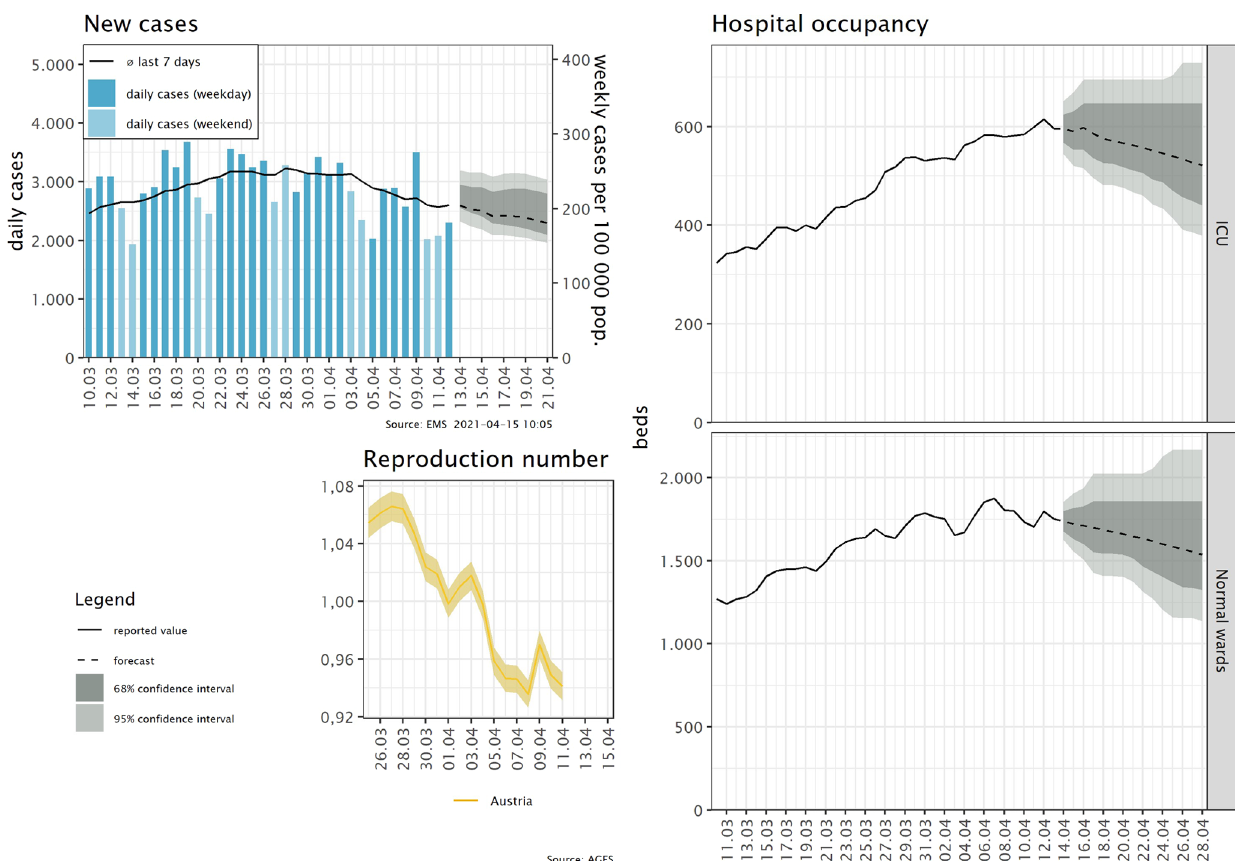
Fig. 5 Example for a reporting template of our out-of-sample forecasts. The visual reports consist of four panels. First, we report the daily number of cases in absolute terms and the weekly case numbers per 100 000 population as well as the forecasts for the weekly case numbers, including CIs. Additional panels show the the effective reproduction number and the forecasts for intensive and normal care beds occupancy with COVID-19 patients along with the corresponding